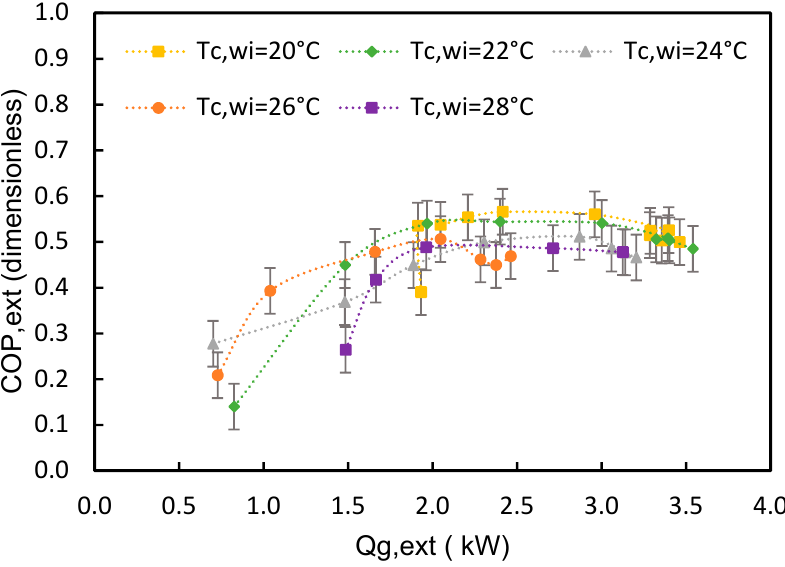
Figure 15. Behavior of the external coefficient of performance (COP) as a function of the generation power.